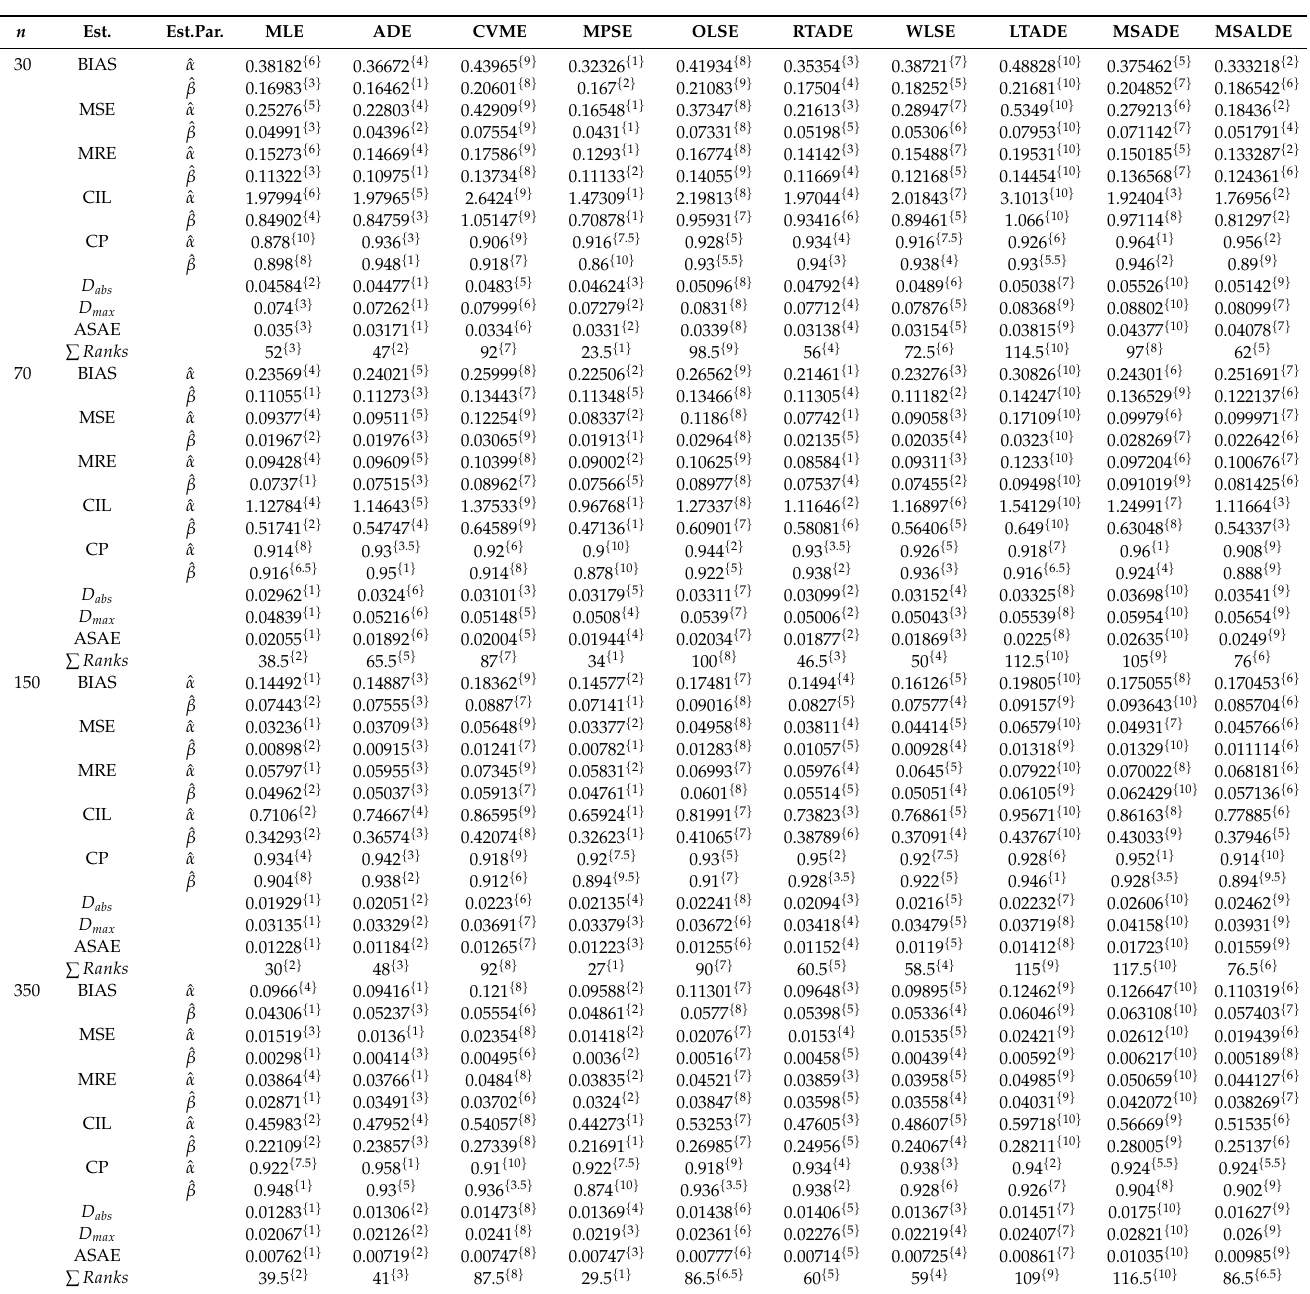
Table 3. Numerical values of PHD simulation for ( α = 2.5, β = 1.5 )